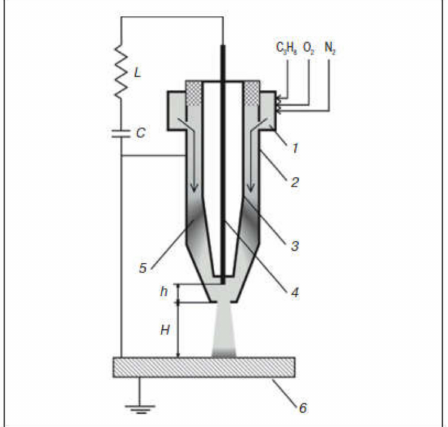
Figure 2. Pulsed-plasma device scheme [16] 1—detonation chamber; 2, 3—coaxial electrodes; 4— consumable electrode; 5—detonation wave; 6—treating